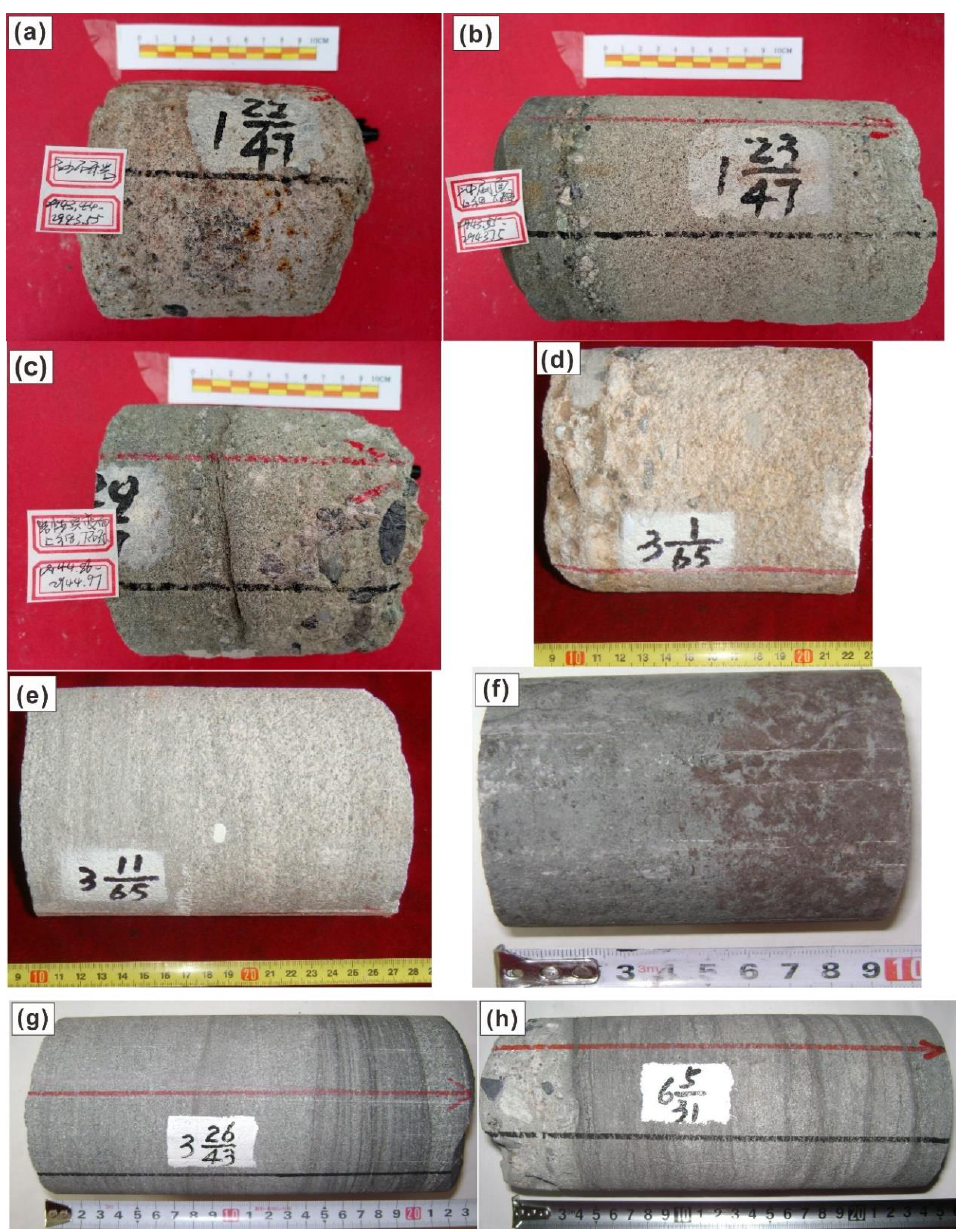
Figure 3. Cores of wells J34, J72 and J91 from the member-1 of the LSF. ( a ) sandy conglomerate at depth of 2943.44 – 2943.55 m, ( b ) mudstone present in the upper part with underlying coarse-grained pebbly sandstone at 2943.55 – 2943.75 m, ( c ) conglomerate to fine sandstone at 2944.86 – 2944.97 m, ( d ) light gray coarse-grained pebbly sandstone intermixed with gray-white oil traces at 2340.84 – 2340.96 m, ( e ) light gray thick-bedded coarse sandstone at 2341.90 – 2342.06 m, ( f ) gray brown mudstone at 2953.19 – 2953.28 m, ( g ) light gray medium sandstone at 2981.08 – 2981.30 m, and ( h ) light gray coarse- gained pebbly sandstone and light gray medium sandstone at 3002.62 – 3002.85 m.